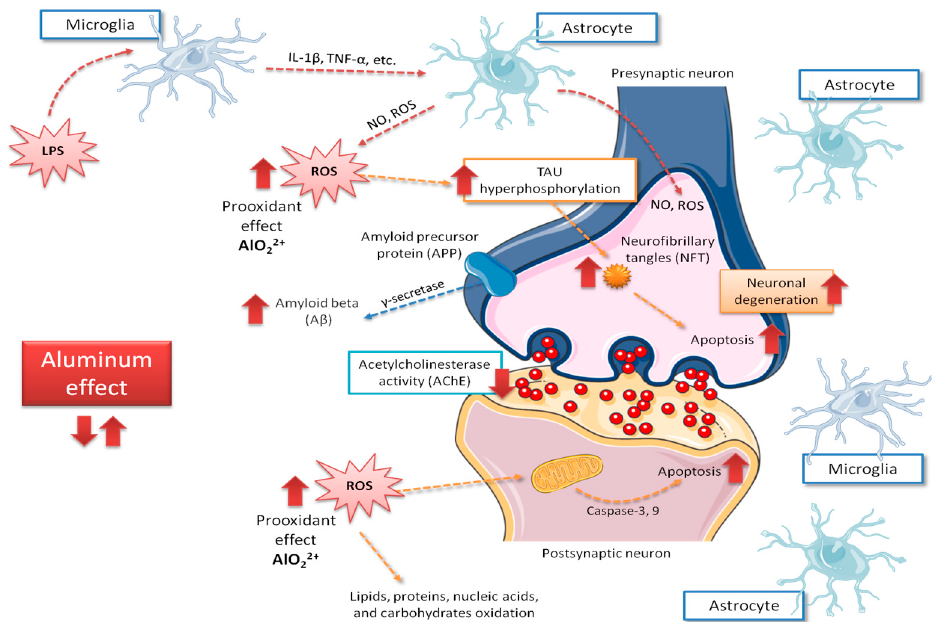
Figure 1. Main central aspects related to neurological mechanisms implicated in Alzheimer’s disease caused by aluminum intoxication. Red arrows indicate the increase of the possible negative effects of aluminum exposure on the brain, those including ROS production increase and, in consequence, rise on tau phosphorylation, apoptosis, amyloid beta peptide (A β ) accumulation and neurodegeneration. IL-1 β , interleukin 1-beta; LPS, lipopolysaccharide; NO, nitric oxide; ROS, reactive oxygen species; TNF α , tumor necrosis factor alpha.